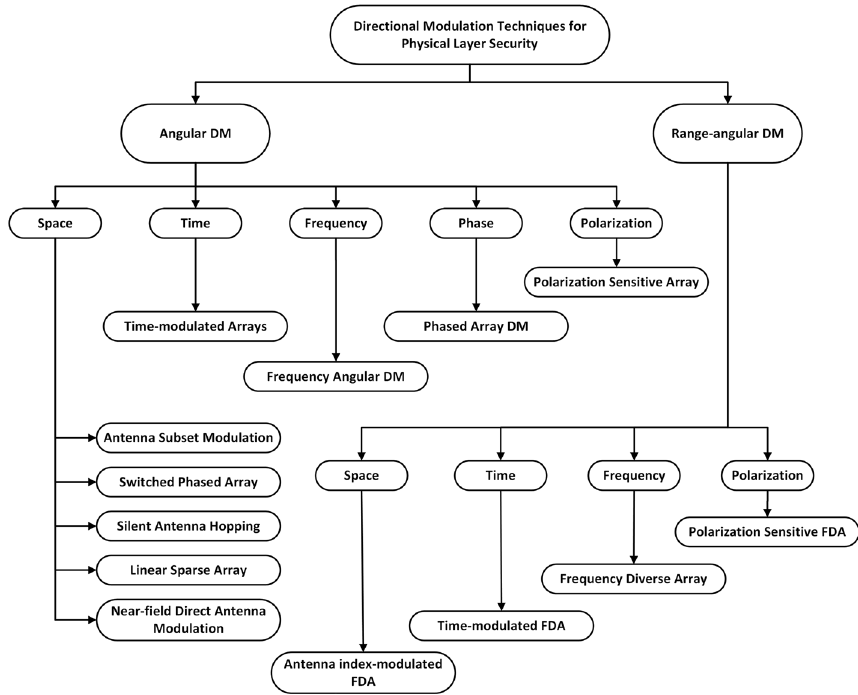
Fig. 3 Taxonomy of directional modulation techniques for physical layer security against passive eavesdropping. This figure captures the essence of the framework proposed in this paper. It categorizes directional modulation techniques into two broad categories; angular and range-angular DM. Angular DM techniques secure data only along spatial angular direction, while range-angular DM techniques transmit secure data along spatial angular direction within specified spatial range of intended receiver. The sub-categorization has been done based on the under-lying physical layer parameter used to achieve security; space, time, frequency, phase and